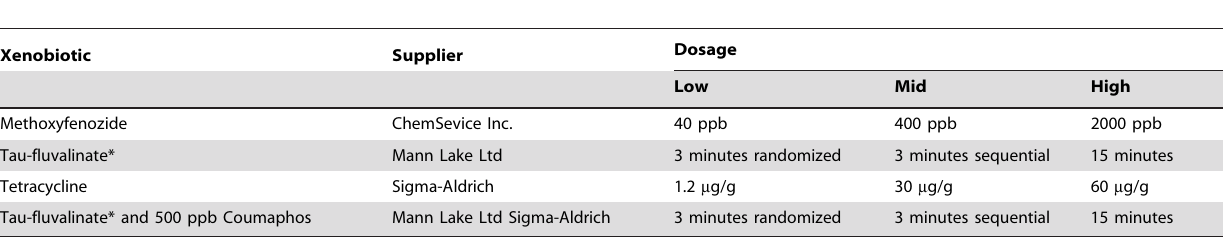
Table 2. Summary of the second experiment testing different dosages of select xenobiotics for effects on intestinal stem cell